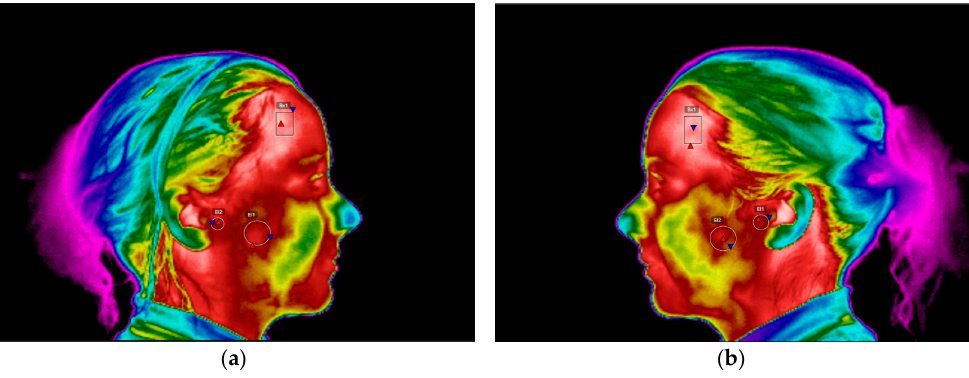
Figure 10. Right ‐ and left ‐ side infrared images of the patient at the end of the treatment. ( a ) Right side thermogram, Bx1 corresponds to the region of interest of the temporal muscle, EI02 corresponds to the region of interest of the TMJ, EI03 corresponds to the region of interest of the masseter muscle; ( b ) Left side thermograms with the contralateral corresponding regions of interest, where it is possible to observe a more symmetrical pattern.